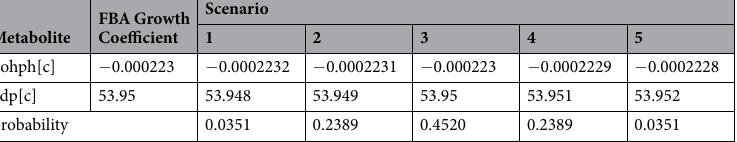
Table 5. The first column is the metabolite name from the iJO1366 model, and the second column contains the associated growth coefficient from the FBA model. The sign indicates whether the metabolite is an input (negative) or output of the growth reaction. The remaining columns are the scenarios for the default case along with their